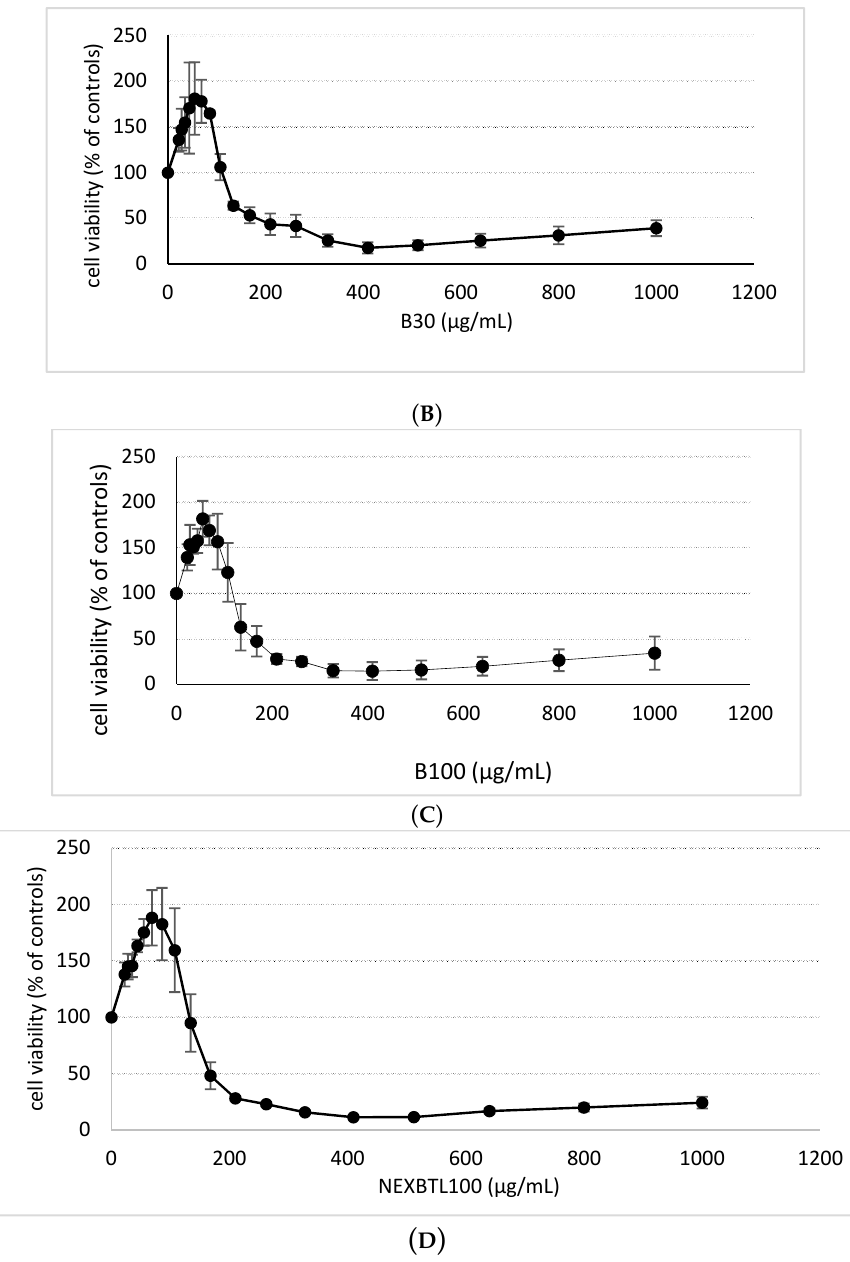
Figure 2. Cell viability evaluated by WST-1 Proliferation Assay. Cells were exposed to 18 different concentrations of: ( A ) B0; ( B ) B30; ( C ) B100; and ( D ) NEXBTL100 extracts for 24 h and the results were expressed as a percentage of increased/decreased activity of mitochondrial dehydrogenases to metabolize tetrazolium dye compared to the untreated control.